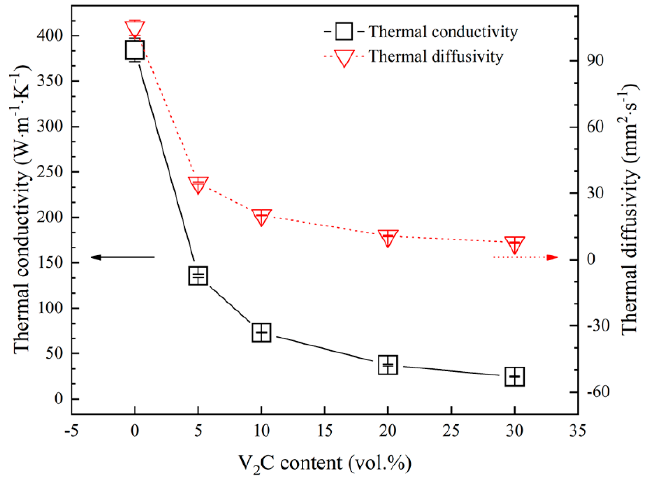
Figure 7. Thermal conductivity and thermal diffusivity of Cu composites as a function of V 2 C content measured at room temperature.